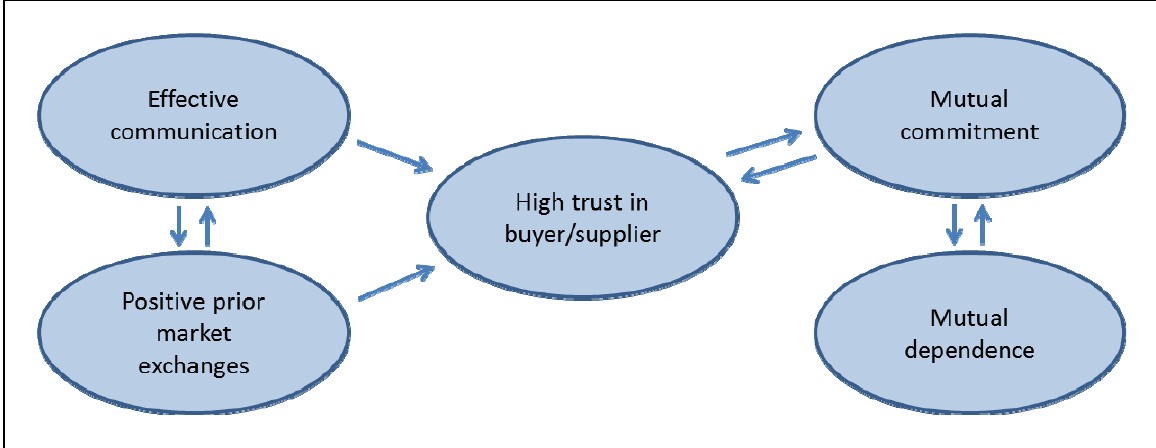
Figure 3. Theoretical Model of the Development of Collaborative Relationships in a Product Supply Chain